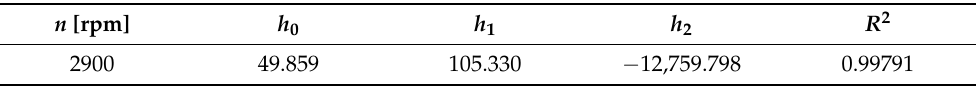
Table 2. The coefficients of the 2nd-degree approximation polynomial function for the pumping head H = f ( Q ) at speed of 2900 rpm.